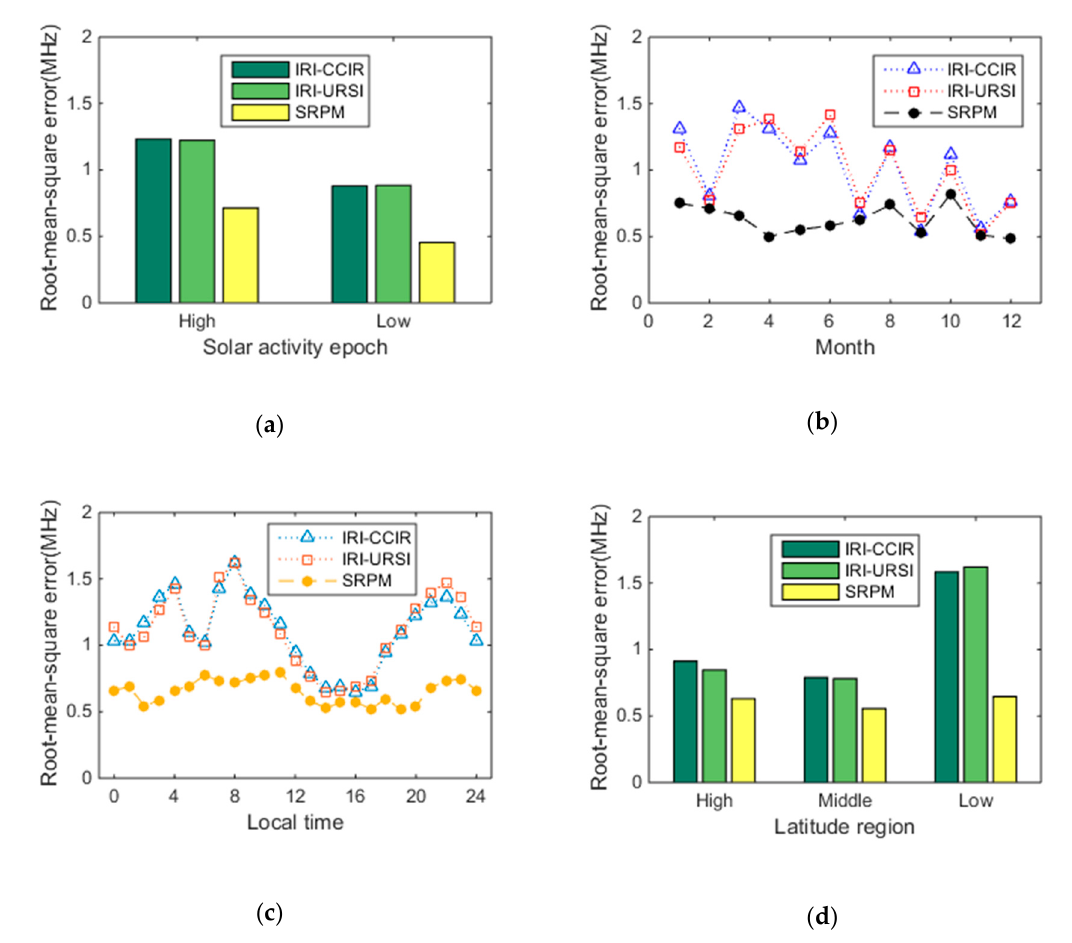
Figure 12. Root-mean-square error between measured value and predicted value of IRI model (using both URSI and CCIR coefficients) and SRPM. ( a ) Root-mean-square error of three prediction method during high and low solar epochs; ( b ) root-mean-square error of three prediction method in 12 months of the total year; ( c ) root-mean-square error of three prediction method at 24 hours of the total day; ( d ) root-mean-square error of three prediction method over high, middle and low latitude regions .